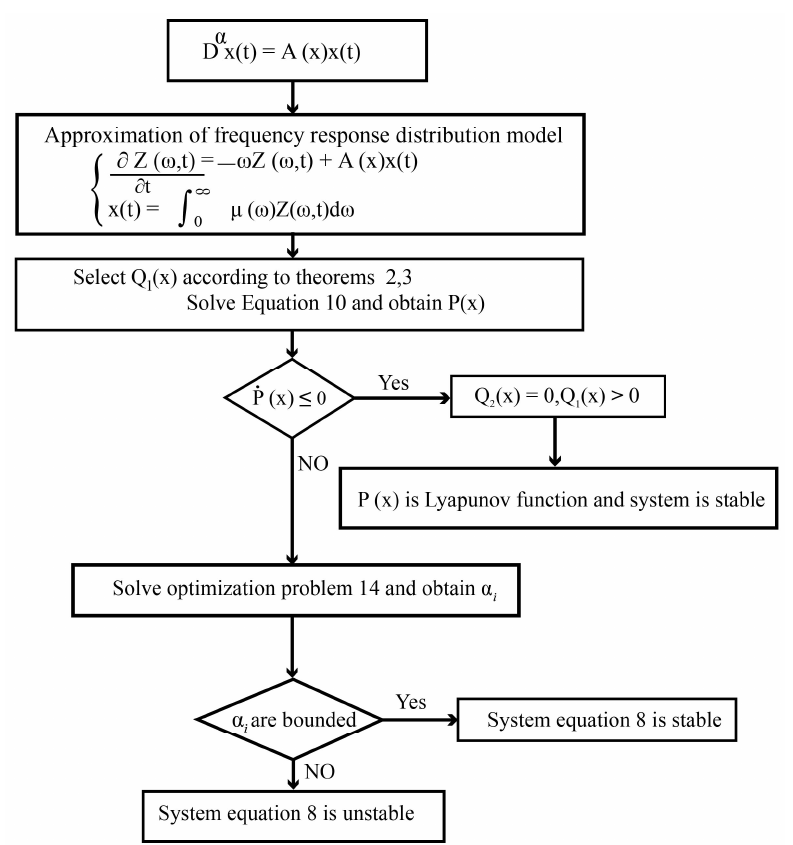
Figure 1. Proposed method to check the stability of fractional-order systems based on the frequency